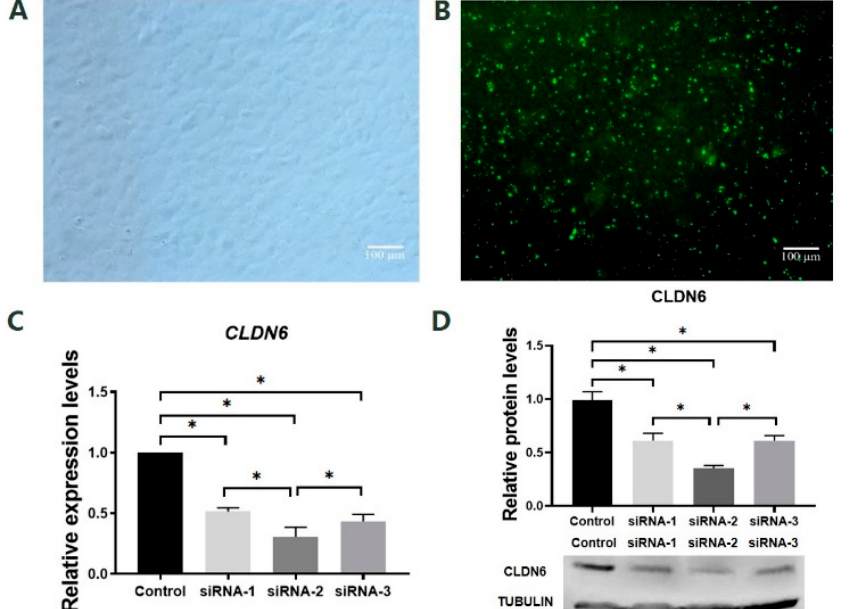
Figure 3. Effects of siRNA targeting CLDN6 gene on its expression at mRNA and protein levels in bovine CCs. ( A ) CCs before siRNA transfection; ( B ) CCs transfected with siRNA; ( C ) The mRNA levels of the CLDN6 gene in cells transfected with different siRNAs; ( D ) CLDN6 protein levels in cells transfected with different siRNAs. Control group was cells transfected with siNC. * p < 0.05. Bar = 100 µm.